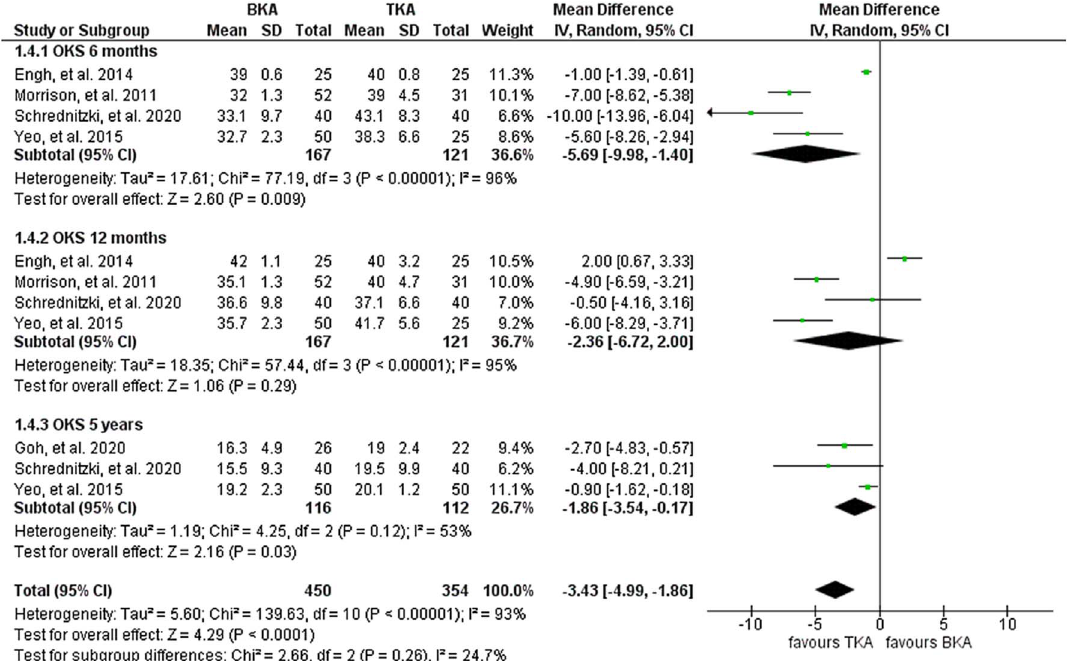
Figure 4. Forest plot of comparison: BKA vs TKA, outcome: OKS after 6, 12 months, and 5 years.